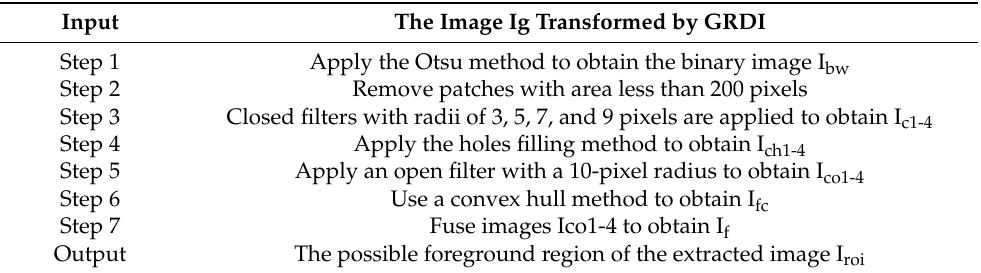
Table 4. The multi-scale filter extraction process of image